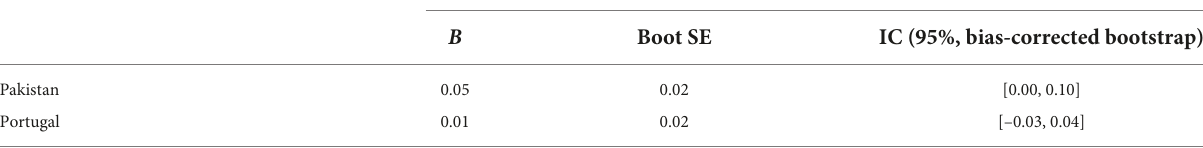
TABLE 3 Analysis of conditional indirect effects of FSSB on satisfaction with